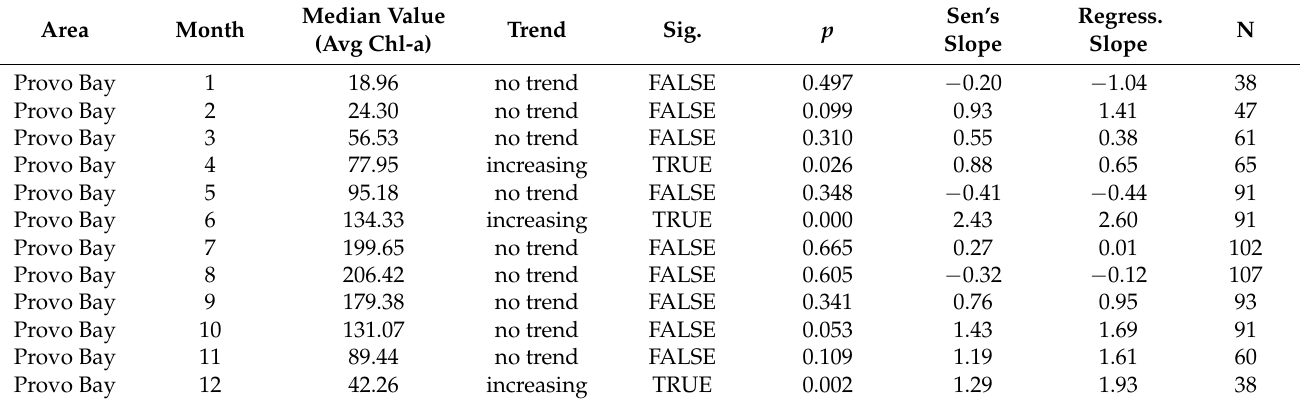
Table 4. Monthly trend analysis for mean chl-a results for Provo Bay excluding winter